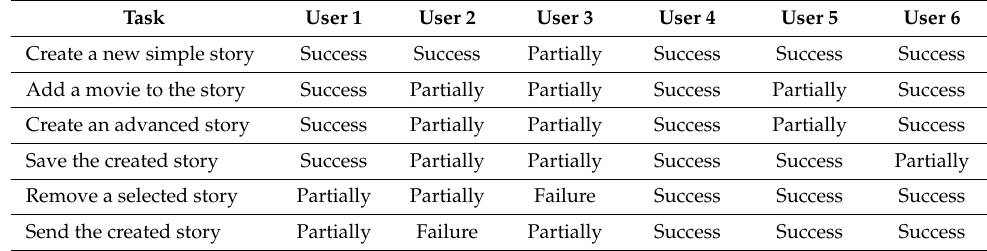
Table 3. Results of the usability test of the Aphastory application.